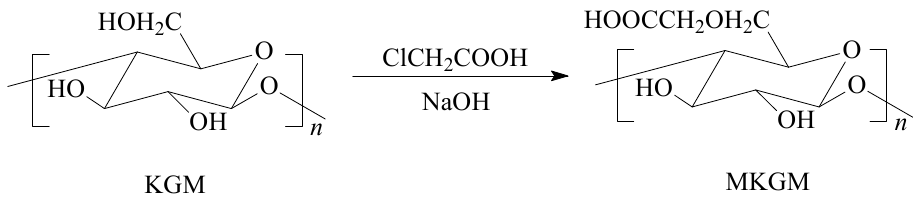
Figure 9. Synthesis of modified MKGM.